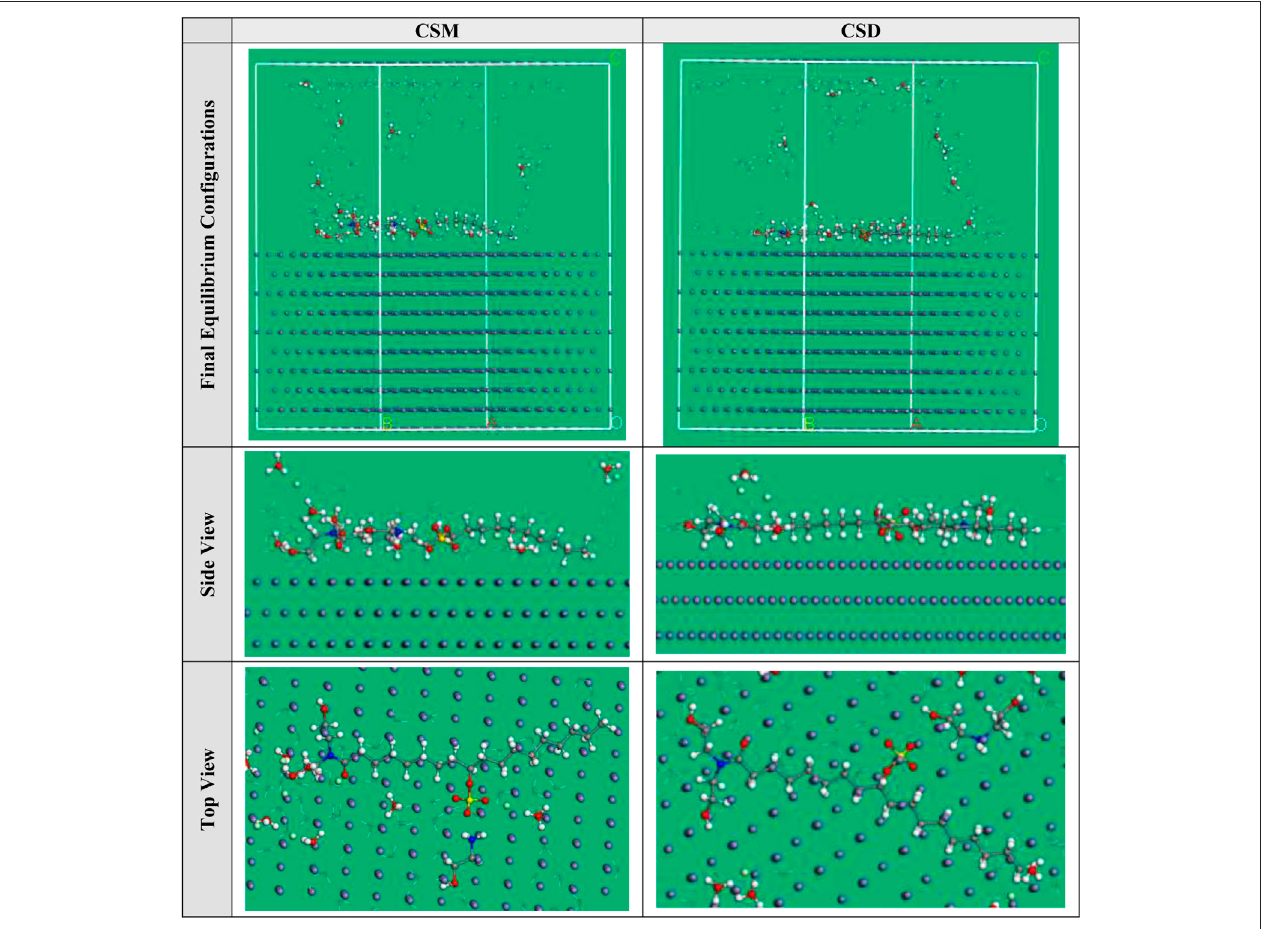
FIGURE11| Mostsuitableadsorptioncon fi gurationforthestructureof (A) CSMand (B) CSDsurfactantsonFe(110)substrateobtainedbytheadsorptionlocator module.